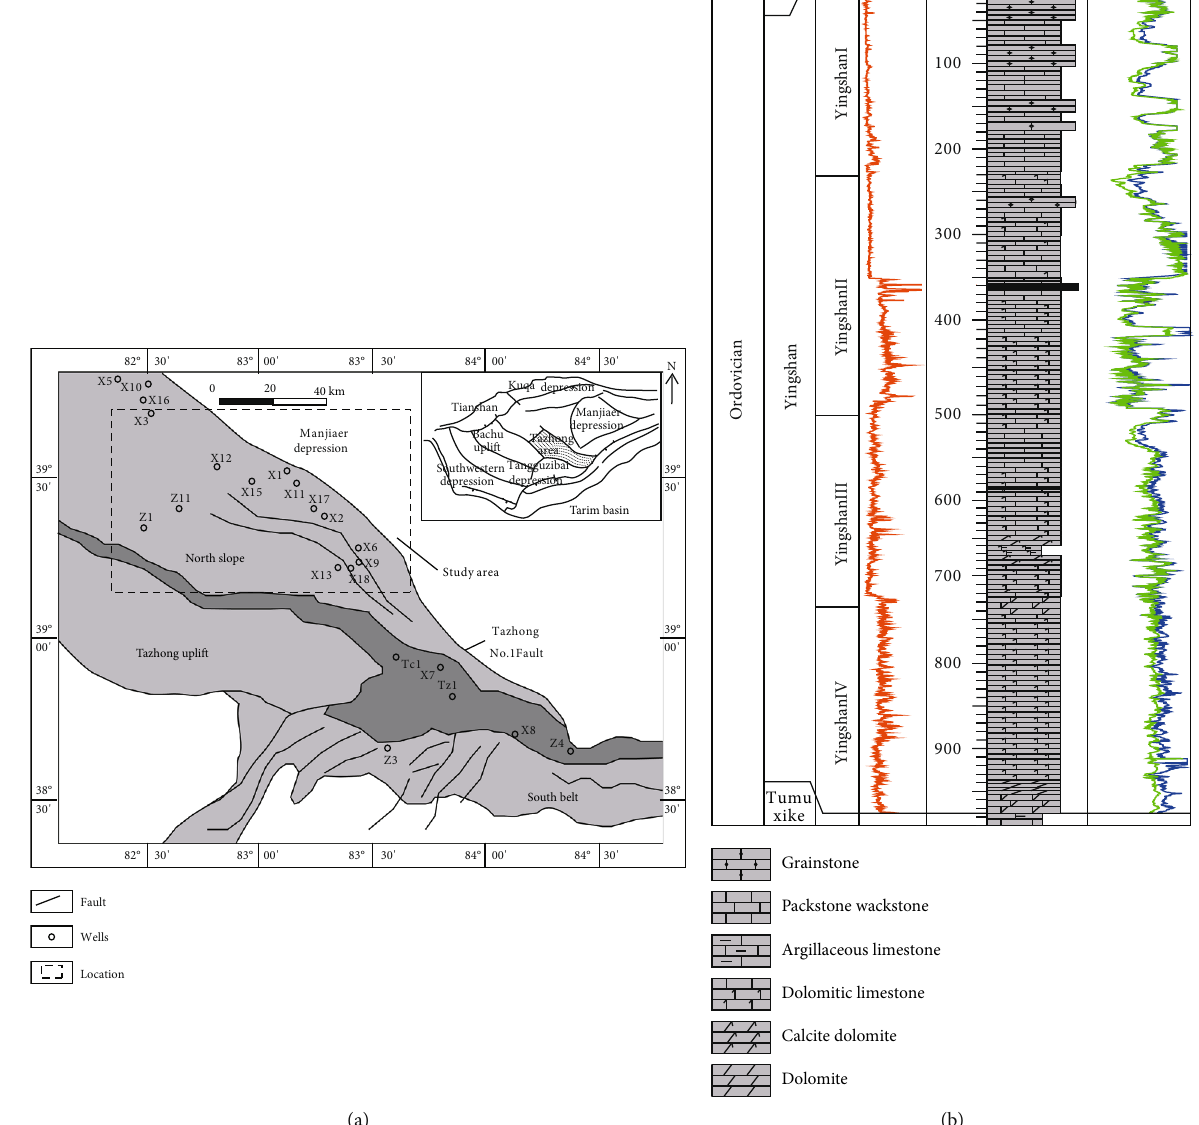
Figure 1: The tectonic location of Tazhong area (a) and composite stratigraphic section of the Yingshan Formation